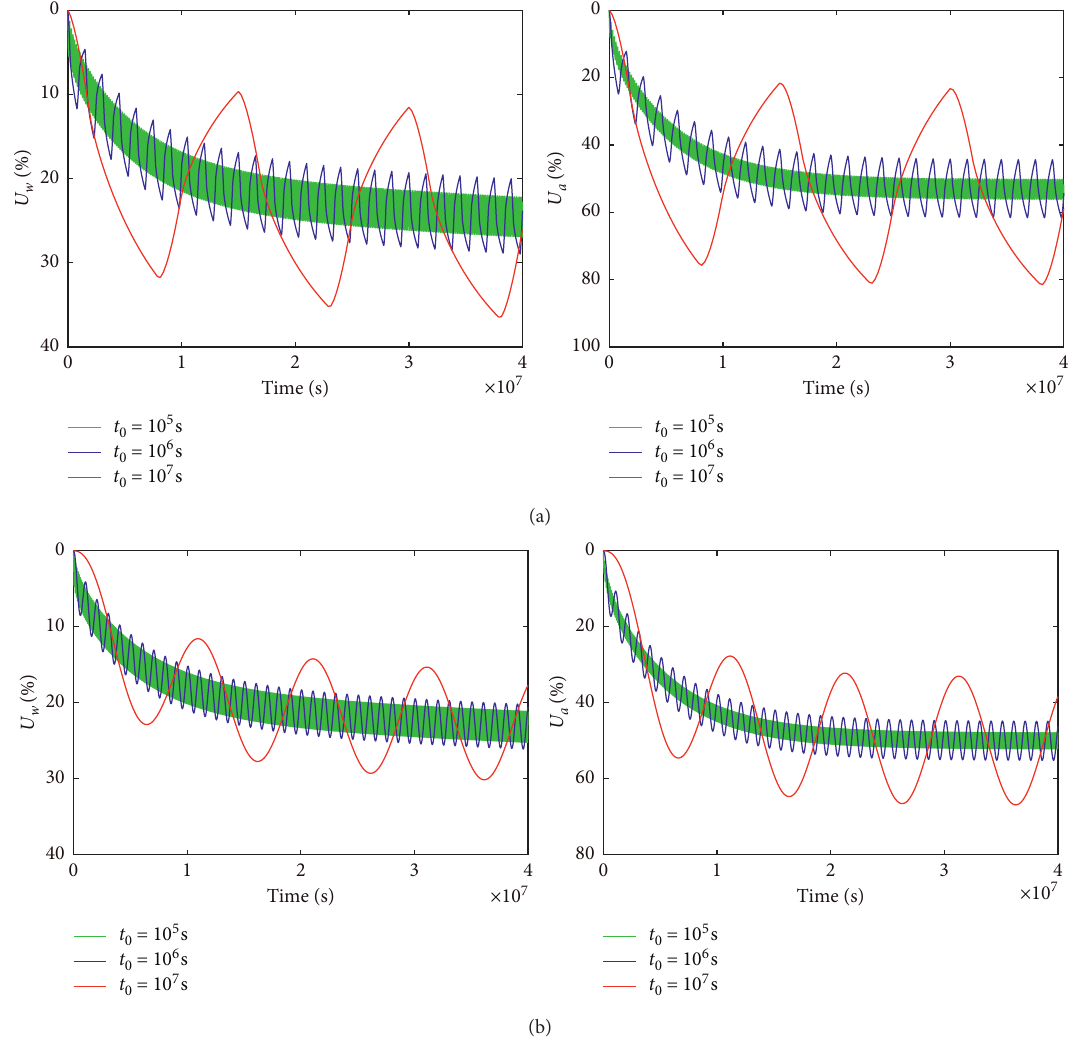
Figure 9: The effects of t on consolidation of unsaturated soils under trapezoidal cyclic loading (a) and haversine cyclic loading 0